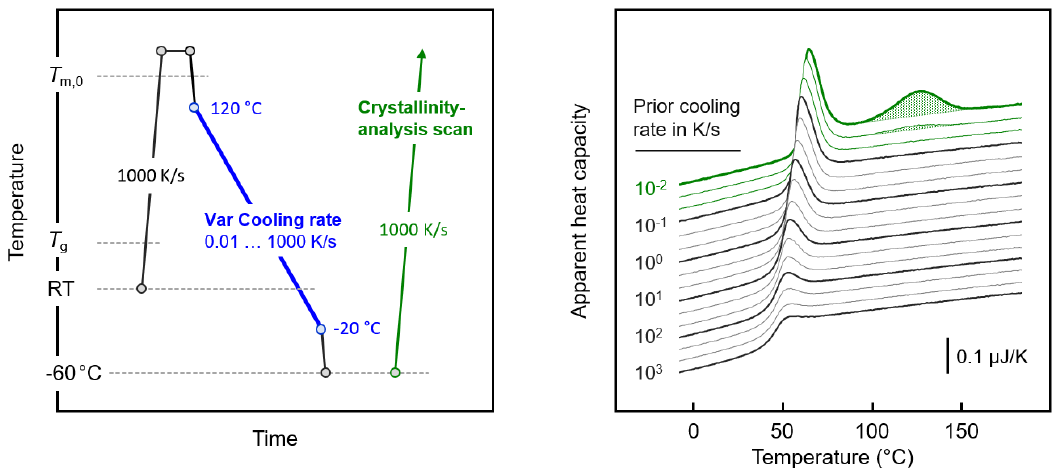
Figure 1. Temperature–time profile for the analysis of the cooling rate dependence of the crystallization of poly(butylene isophthalate) PBI ( left ), and fast scanning chip calorimetry (FSC) heating scans for the analysis of the formation of crystals during prior cooling at rates of 1000, 500, 200, 100, 50, 20, 10, 5, 2, 1, 0.5, 0.2, 0.1, 0.05, 0.02, and 0.01 K/s (from bottom to top) ( right ).